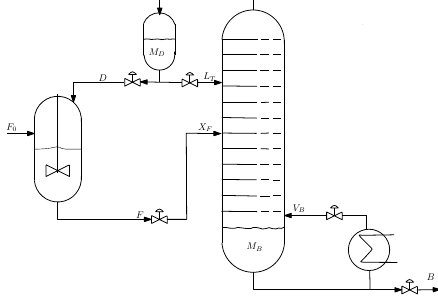
Figure2. DiagramofCSTRandDistillationColumn Figure 2. Diagram of continuously-stirred tank reactor (CSTR) and distillation Table2. DistillationcolumnAparameters